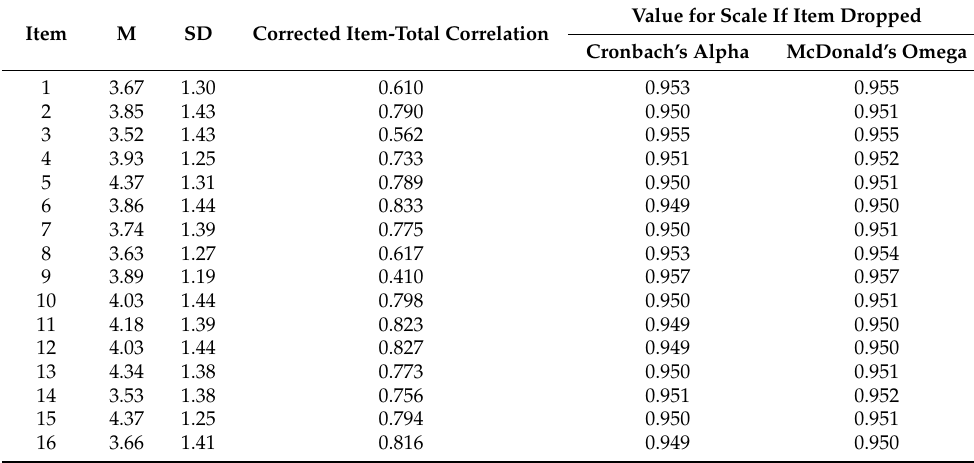
Table 5. Reliability statistics for DSES items in Sample 1.